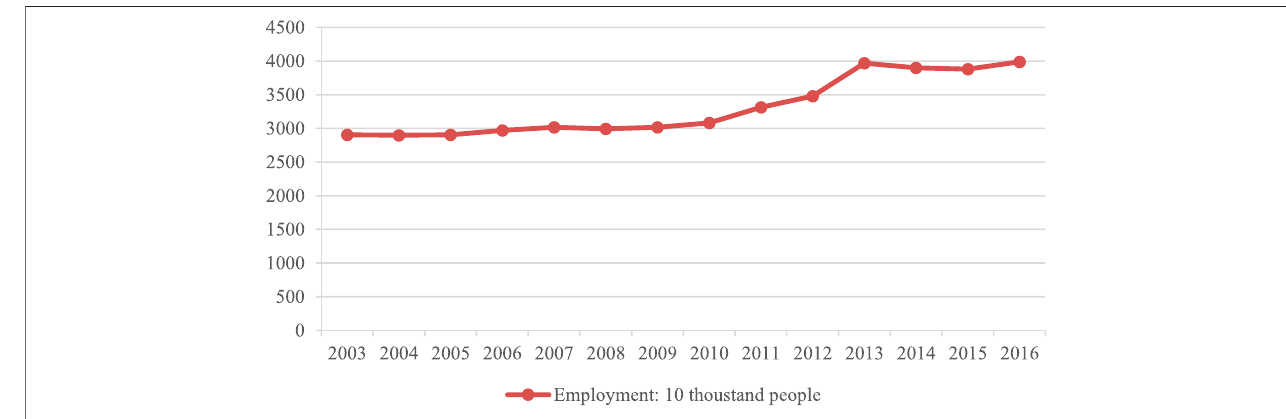
FIGURE 1 | Employment in resource-based cities.